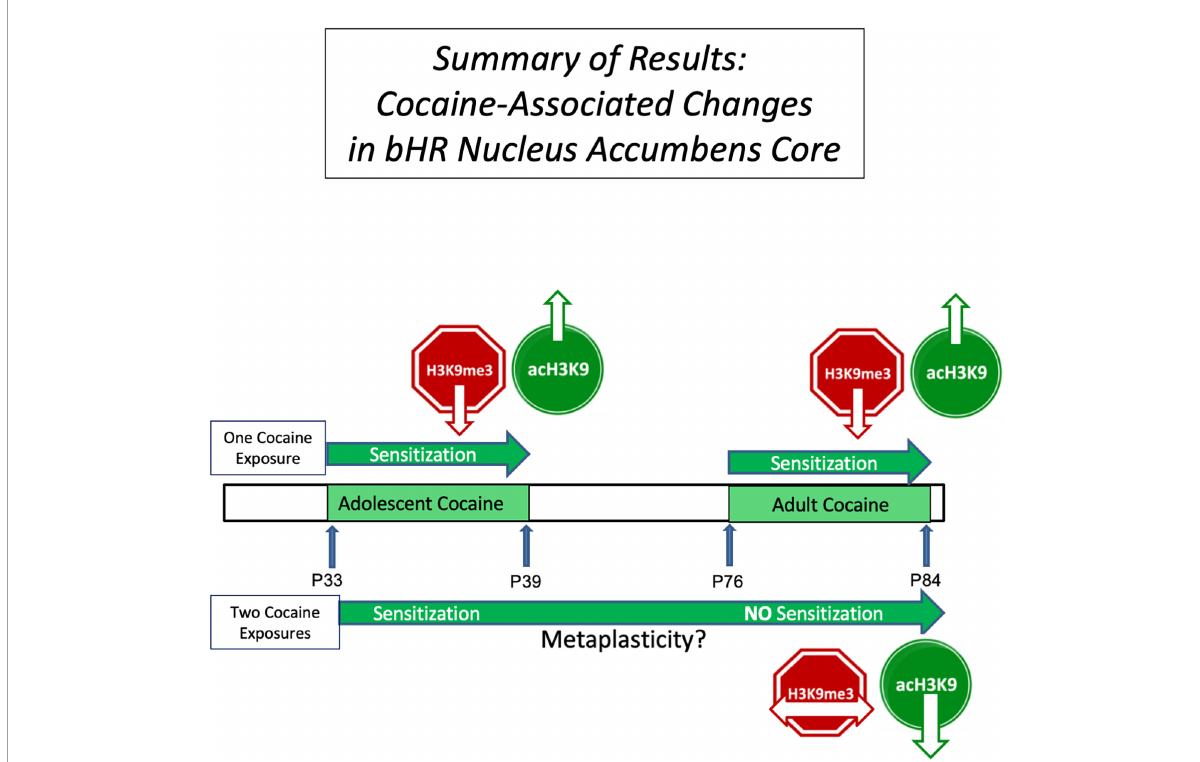
FIGURE5 Summary of the Results: This figure summarizes some of the results of this study and serves as a framework for further work testing the potential causative role of these epigenetic changes in cocaine sensitization. It focuses on the nucleus accumbens core of bHR rats (downward arrow indicates a decrease, upward arrow an increase, and horizontal arrow no change). The top bar illustrates the findings in bHRs receiving cocaine only once, either in adolescence or in adulthood, compared to those receiving saline at the same time. We observed a decrease in repressive histone, H3K9me3 (red) and increased permissive histone, acH3K9 (green), associated with cocaine sensitization in both adolescence and adulthood. The lower bar shows bHR rats with a history of cocaine exposure in adolescence. Thus, they received cocaine twice (Coc-Cocaine), and are compared to those who received saline in adolescence (Sal-Cocaine). bHRs with a history of adolescent cocaine exposure show no evidence of behavioral sensitization in adulthood and no change in H3K9me3. This decreased evidence of behavioral and neural plasticity following previous experience is consistent with the notion of